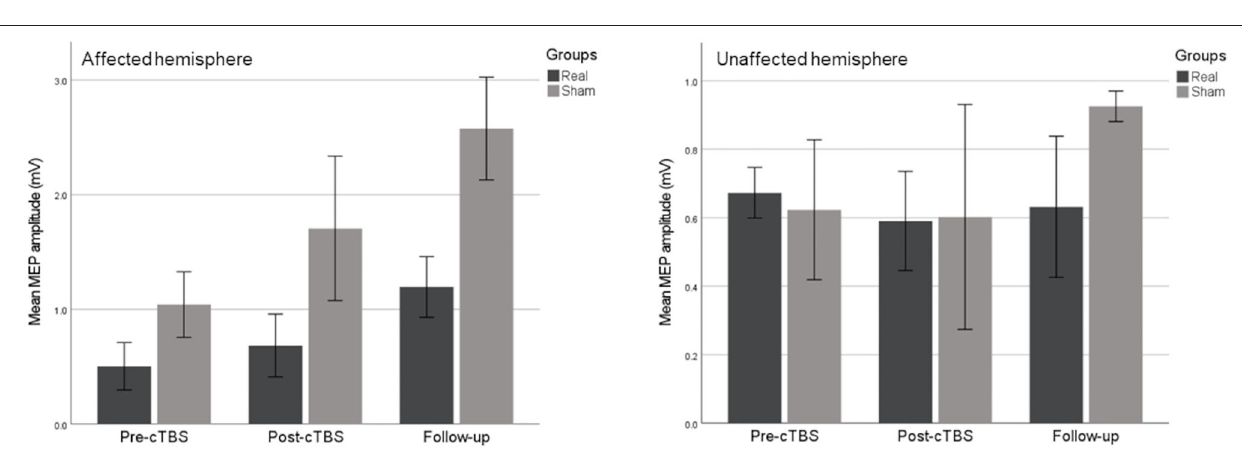
FIGURE 4 | Non-significant changes in motor-evoked potentials of the affected (left chart) and unaffected (right chart) hemispheres. Error bars show ± 1